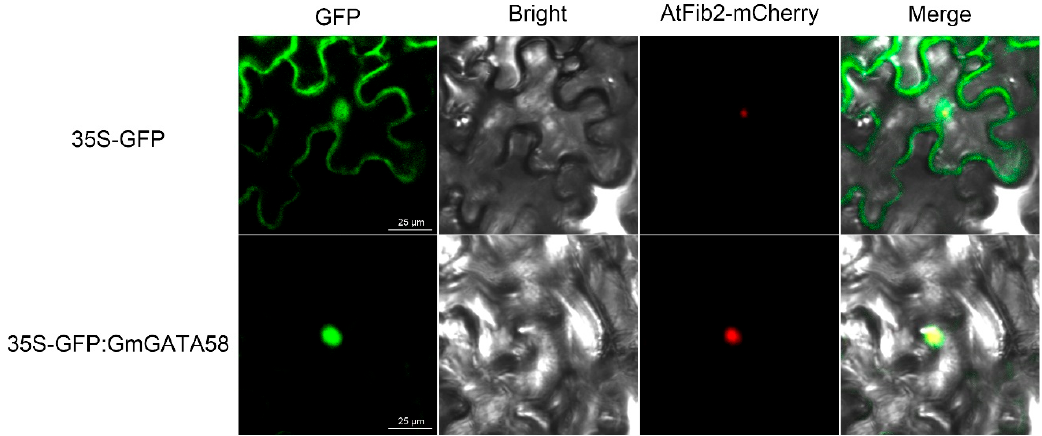
Figure 1. Subcellular localization of GmGATA58 protein in leaves of Nicotiana benthamiana using Agrobacterium -mediated transient expression. The plasmid construct containing GFP alone or GFP::GmGATA58 fusion protein was co-transformed into leaves of N. benthamiana with AtFib2-mCherry construct (nucleolar marker) and fluorescence signals were visualized using a confocal laser scanning microscopy 3 d after infiltration. GFP—(green), mCherry—(red), white—and their merge images were shown. Scale bar = 25 μ m.